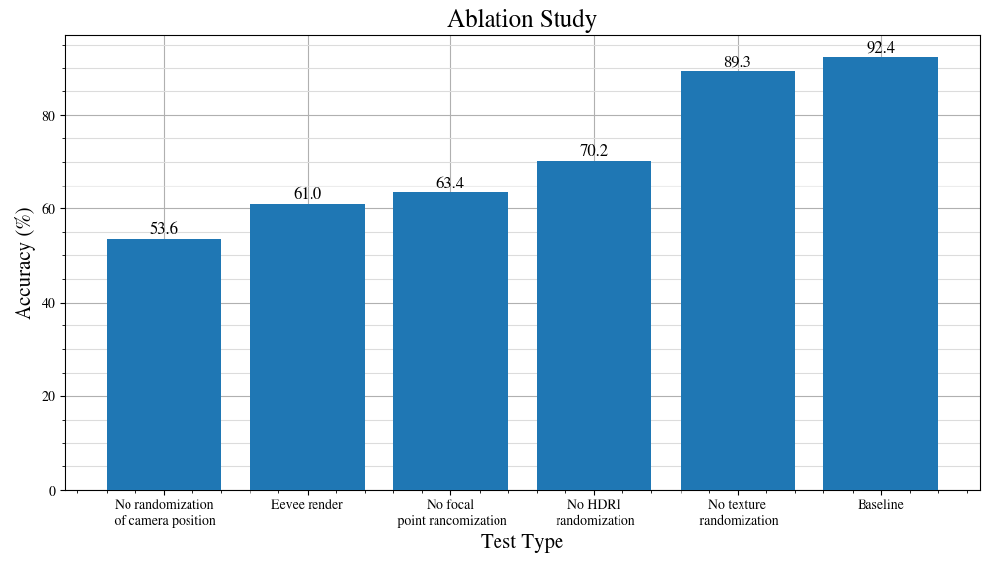
Figure 7. Impact on the accuracy of the neural network by omitting individual randomized compo- nents from the data generation procedure described in Section